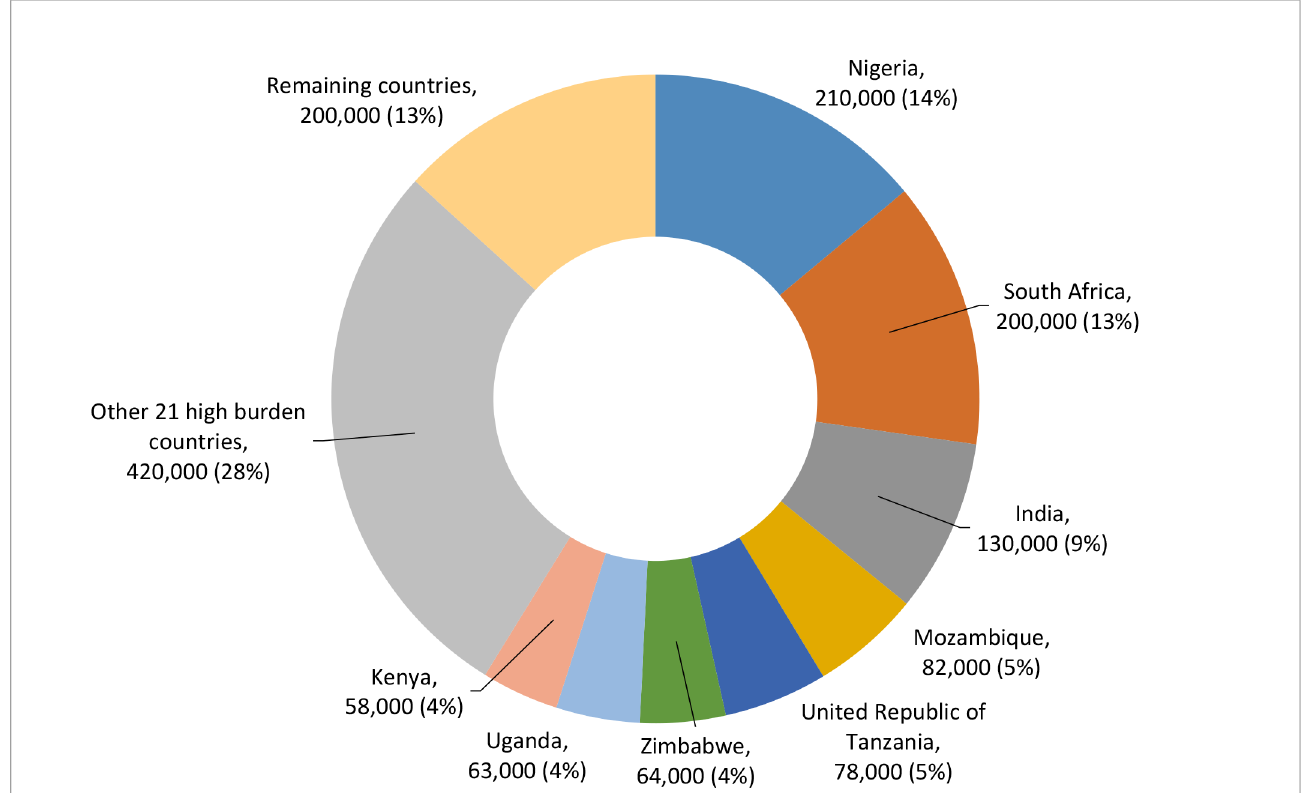
Fig 1. Estimated annual AIDS-related deaths by country, 2013. Number and percentage of estimated 1.5 million (1.4 million – 1.7 million) global AIDS- related deaths in the eight highest burden countries for 2013.